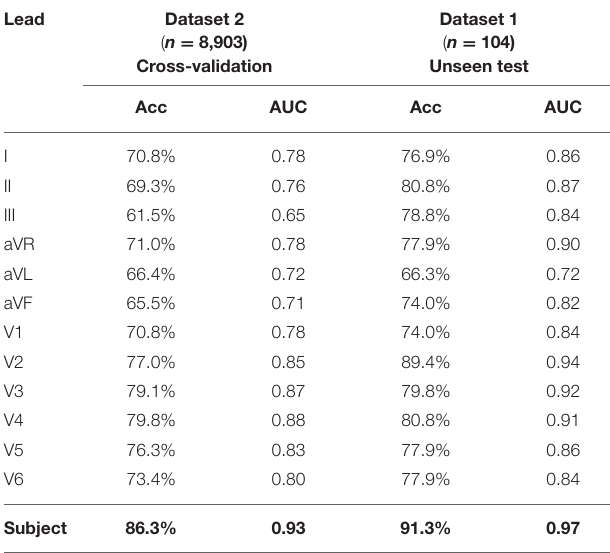
TABLE 1 | Accuracy of classification of sex by lead and